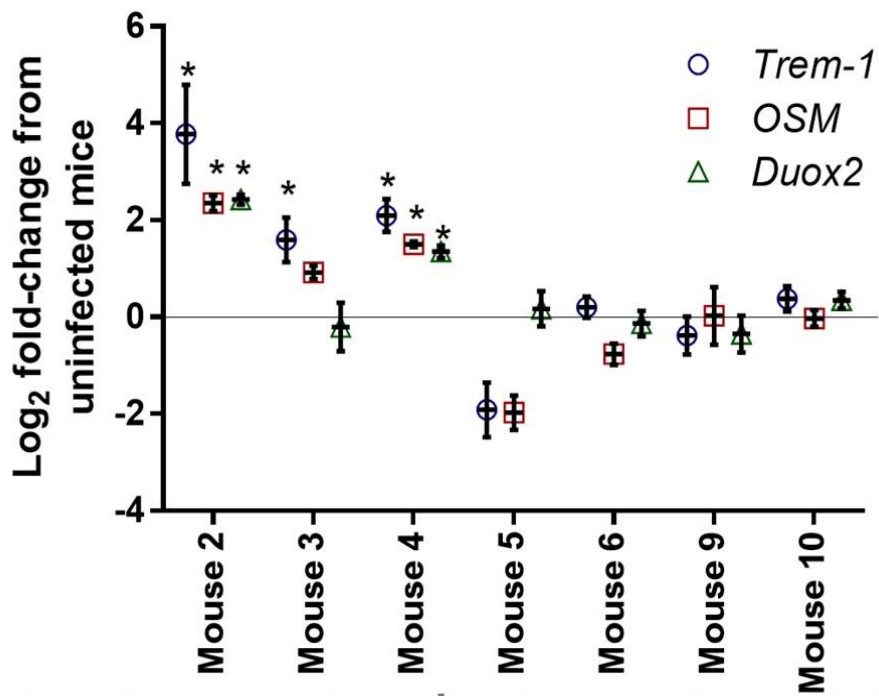
Figure 3. Quantitative PCR (Q-PCR) confirmation of the upregulation of Trem-1 , OSM, and Duox2 in infected symptomatic mice (2, 3, and 4). No upregulation is observed with asymptomatic (5 and 6) or uninfected (9 and 10) mice. (*) denotes significant difference from the control (uninfected) average using one-way analysis of variance (ANOVA) followed by Tukey’s multiple comparisons test.